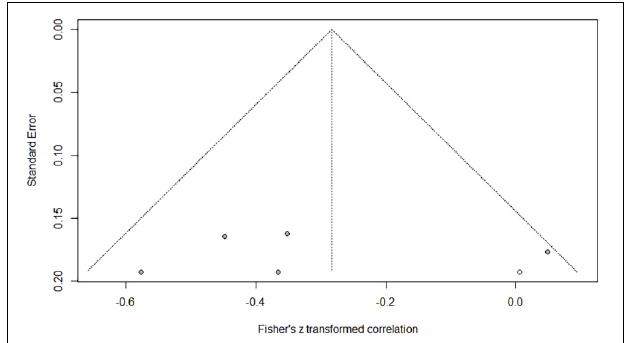
FIGURE 7 | Funnel plot of effect sizes vs. standard error for orthographic awareness and Chinese word reading.